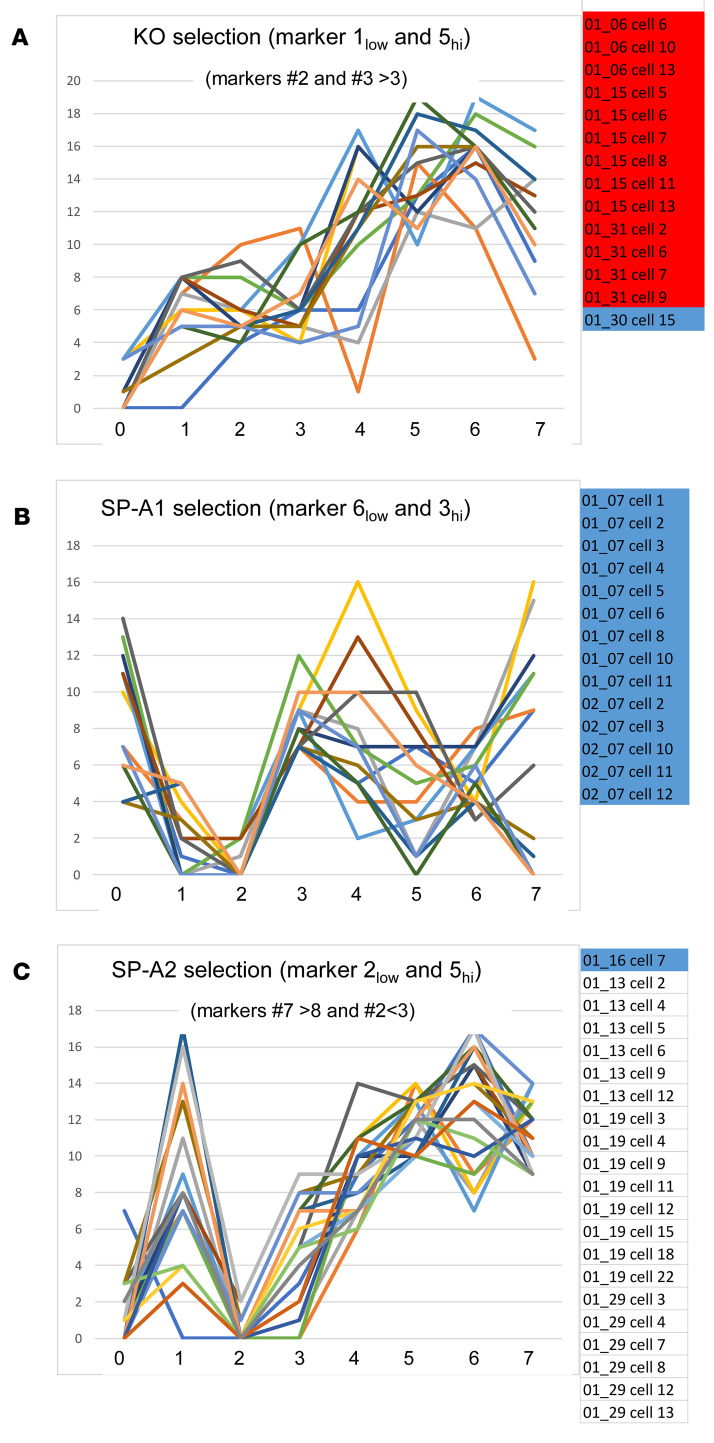
Selection criteria to define exclusive (or highly enriched) phenotypes.The lists of included cells (on right) are color-coded as in Figure 8. Examples are shown for enriched selections of KO cells (A), SP-A1 cells (B), and SP-A2 cells (C). In each graph, the title indicates the main selection criteria (i.e., low levels of biomarker 1 and high levels of biomarker 5 in panel A). Other selection criteria used are shown in smaller type under the main panel titles (i.e., biomarkers 2 and 3>3 in panel A). The identity of the biomarkers is given (Table 1).